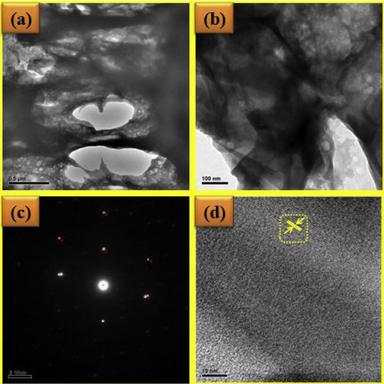
TEM images of optimized (a) CAT, (b) CATCL NPs, (c) SAED pattern and (d) HRTEM image of CATCL NPs.